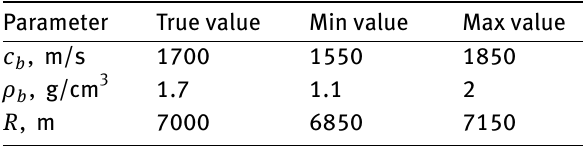
Table 3: Intervals and true values of the unknown parameters. Parameter